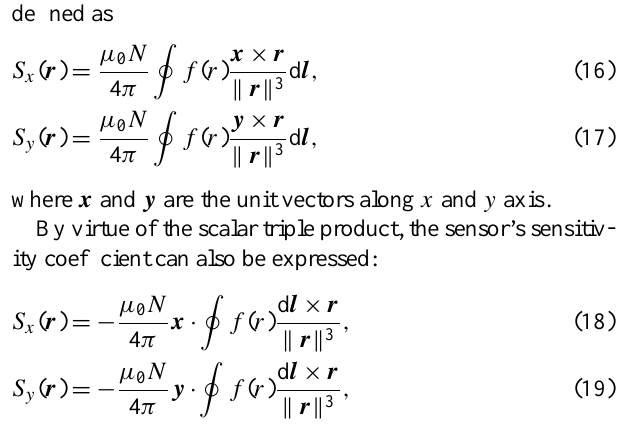
Figure 3. Illustration of the ribbon solenoid